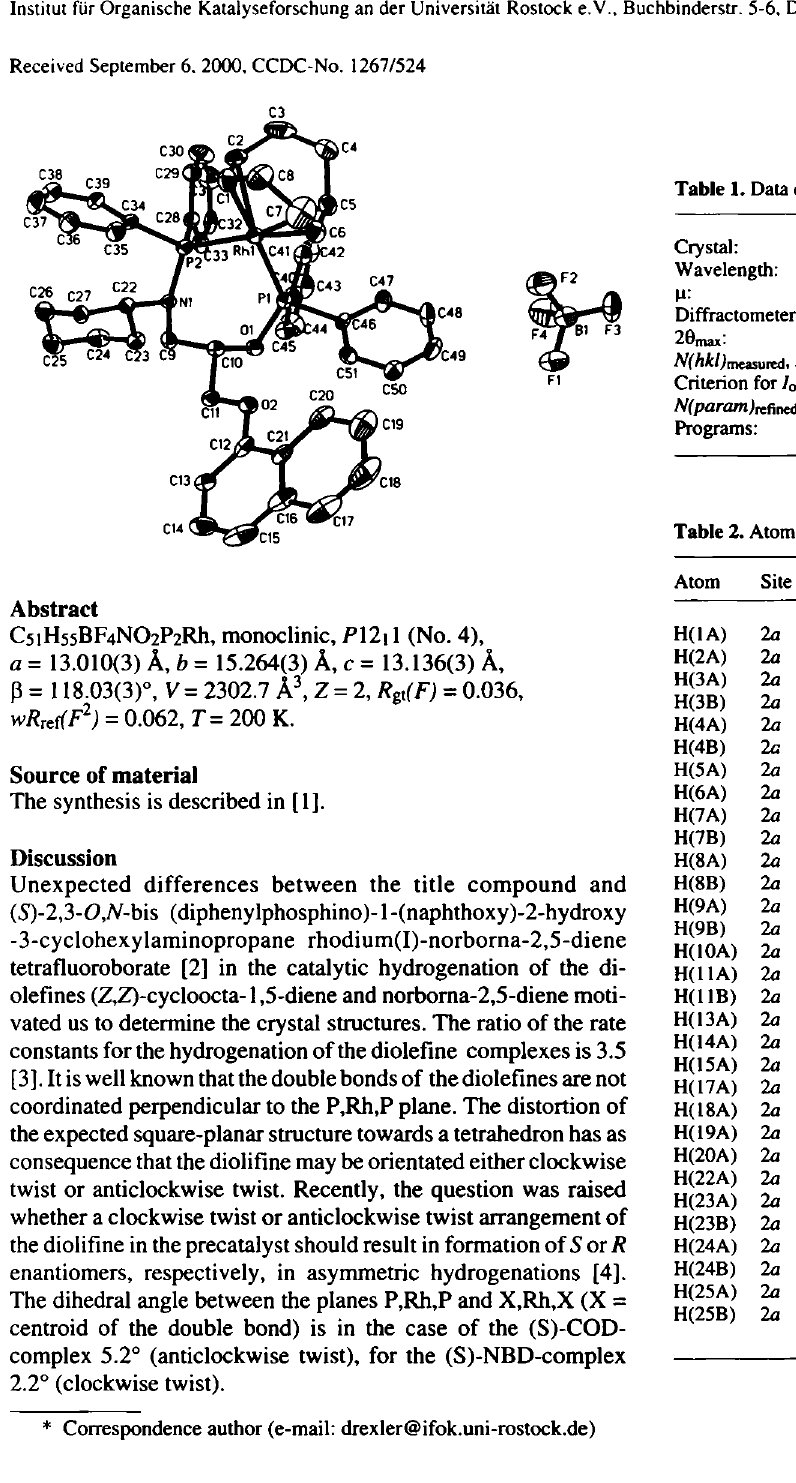
Table 1. Data collection and handling.